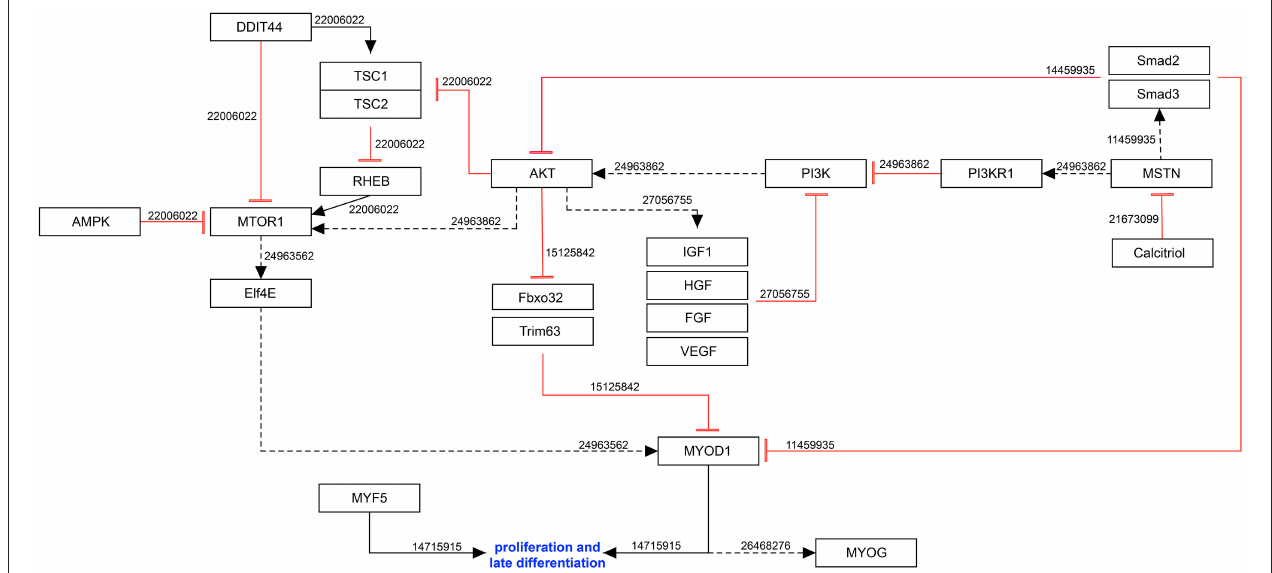
FIGURE 2 | Molecular mechanisms involved in myogenic proliferation during hypoxia. Black arrow: activation of the signaling pathway/protein/molecule. Blunt red arrow: inhibition of the signaling pathway/protein/molecule. Numbers: PubMed-IDs.